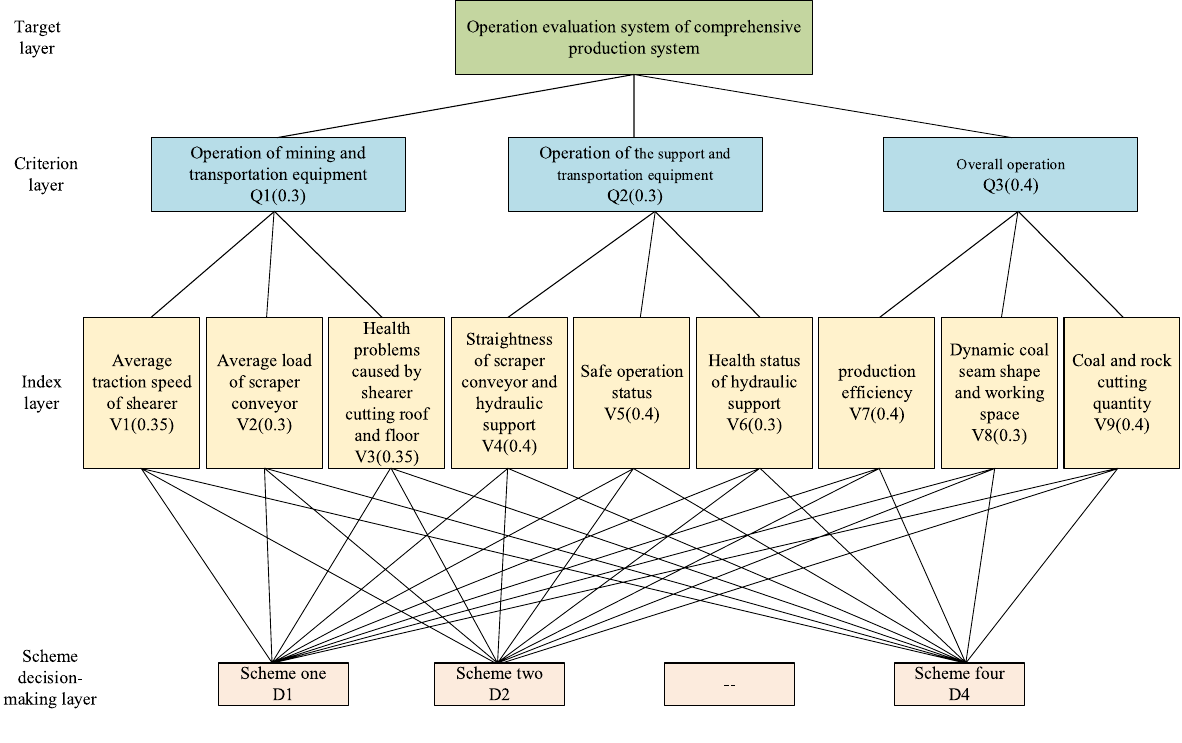
Fig. 10 Evaluation index model for coal mining health and